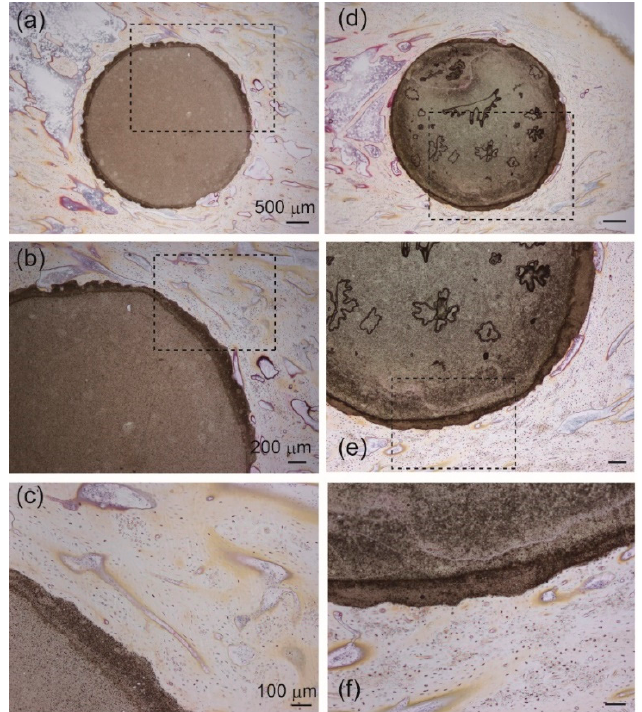
Figure 10. Histological observations (Villanueva bone staining) in Ag-TCP(0) and Ag-TCP(5) cements at 8 weeks after the operation. Left panels ( a – c ) showed Ag-TCP(0) cements and right panels ( d – f ) represent Ag-TCP(5) cements. ( b , e ) show higher magnification of the rectangular area in ( a , d ). ( c , f ) represent higher magnification of the rectangular area in ( b , e ). Scale bars indicate 500 µ m ( a , d ), 200 µ m ( b , e ), and 100 µ m ( c , f ), respectively.